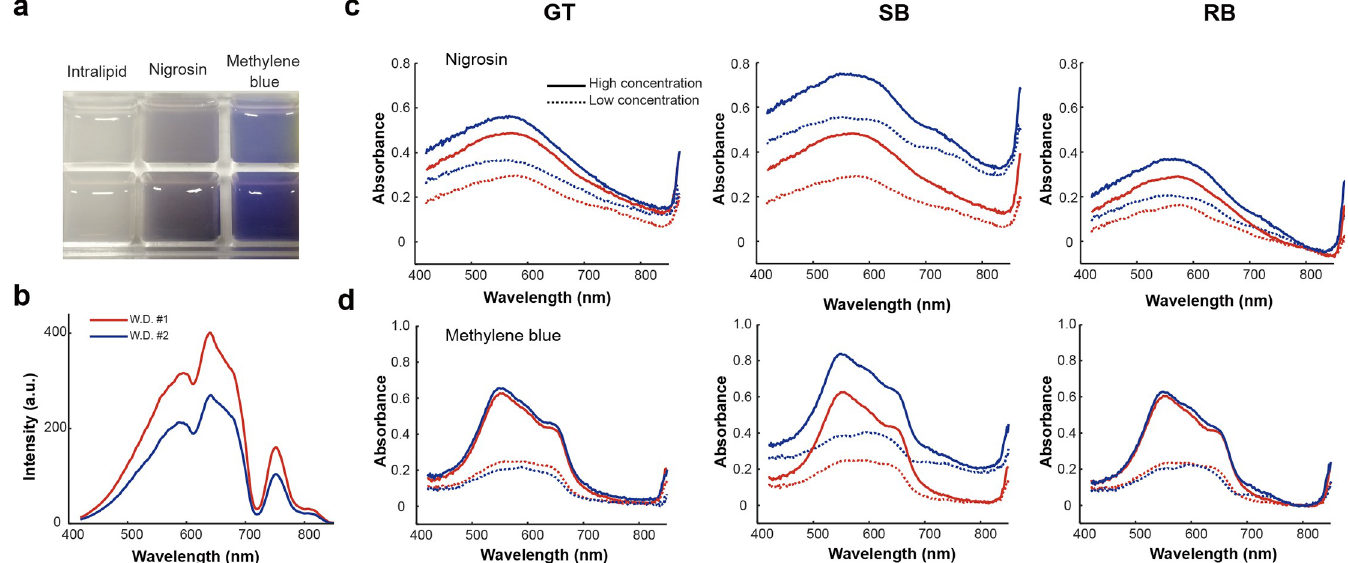
Fig 4. Background correction using the retrieved background method performs favourably in measurement of the absorbance spectra of nigrosin and methylene blue (a) Photograph of tissue-mimicking phantoms with intralipid (control), nigrosin (absorbing dye), and methylene blue (fluorescent dye). (b) Experimentally measured reflectance signals of the control phantom (intralipid only) at two different working distances gave the ground-truth background. (c) Absorbance of low and high concentrations of nigrosin dye calculated using the ground truth background (GT), single background (SB) and our retrieved background (RB) method respectively. (d) Absorbance of low and high concentrations of methylene blue calculated using GT, SB and RB methods respectively.